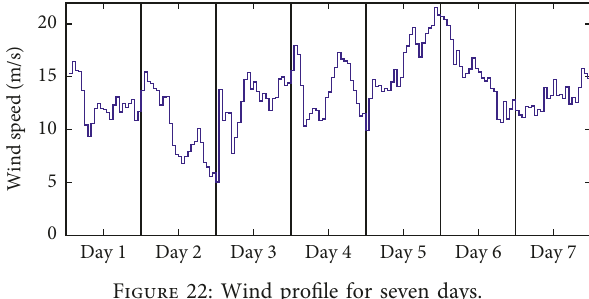
Figure 22: Wind profile for seven